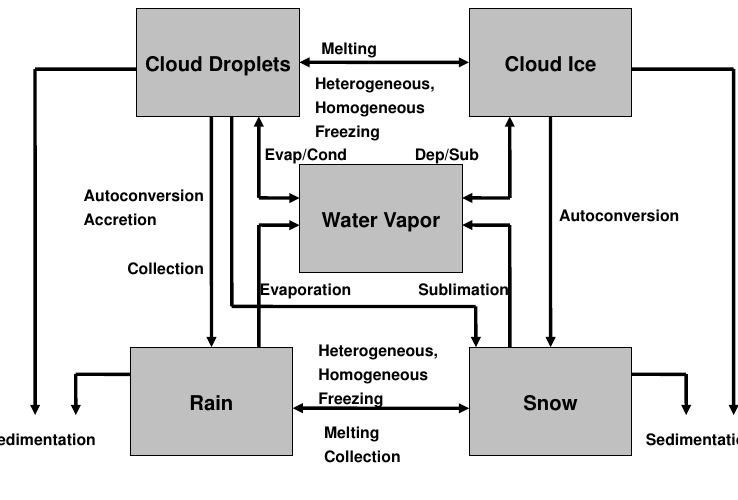
Fig. 1. Schematic: processes in the Morrison and Gettelman (2008) microphysics scheme (after Morrison et al., 2005).